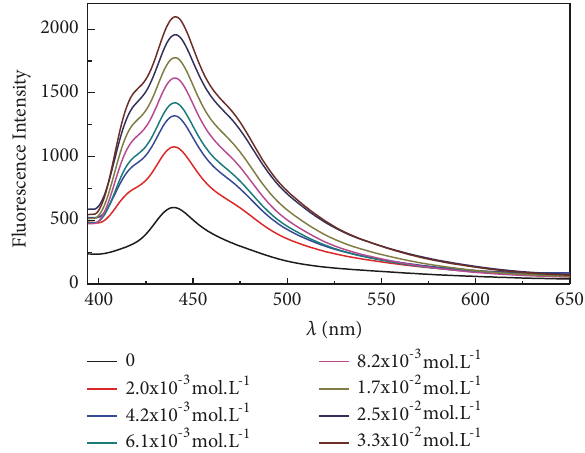
Figure 1: Fluorescence behaviors of 𝑛 -B 18 H 22 during the micelliza- tion of surfactant SDS in aqueous